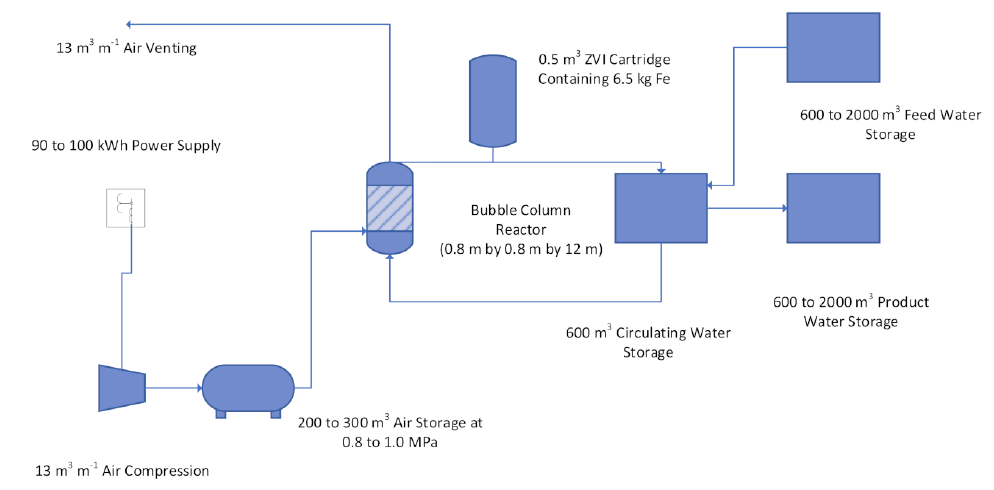
Figure 6. Expected plant layout associated with a 650 train reactor, processing 550 m 3 d − 1 (200,750 m 3 a − 1